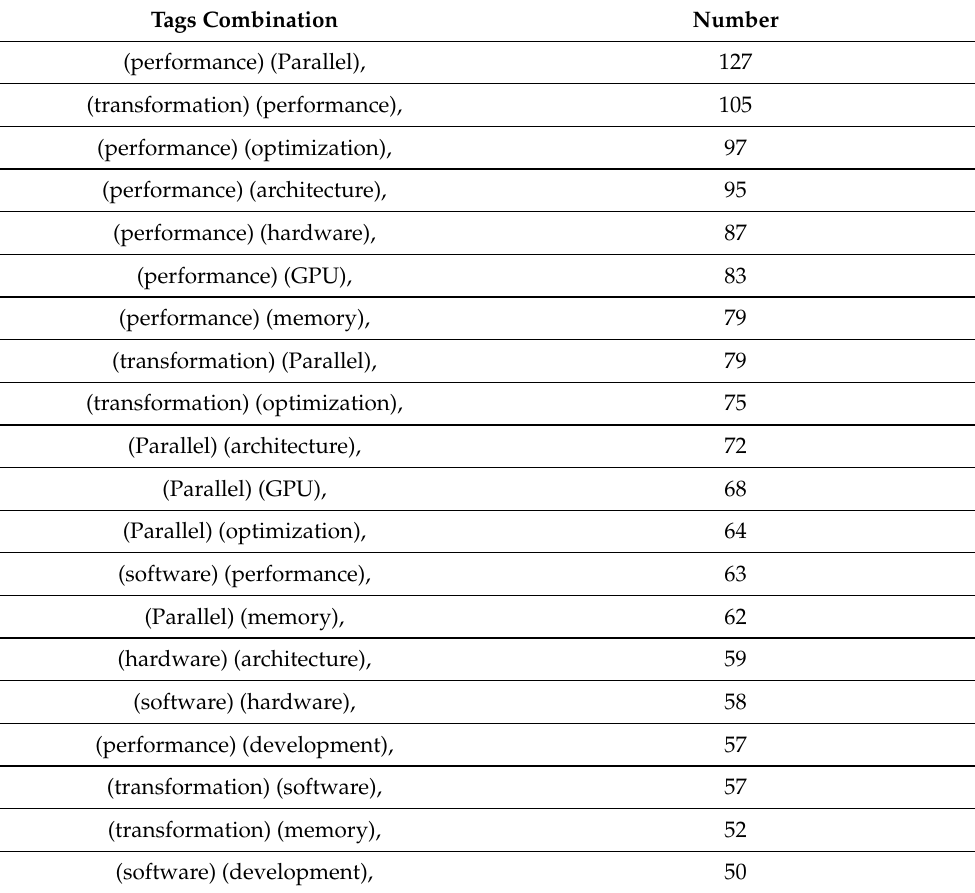
Table 13. Co-ocurrence